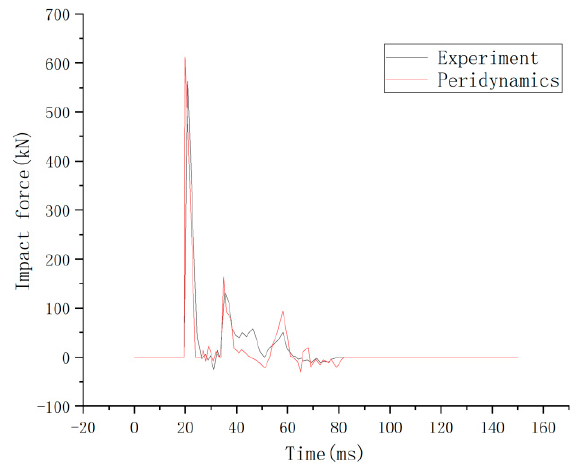
Figure 13. Time histories of impact force [14].